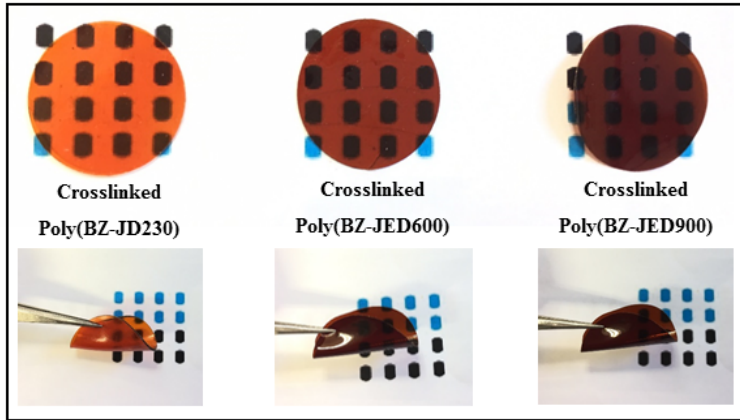
Figure 3. Physical appearance of crosslinked polybenzoxazine films.